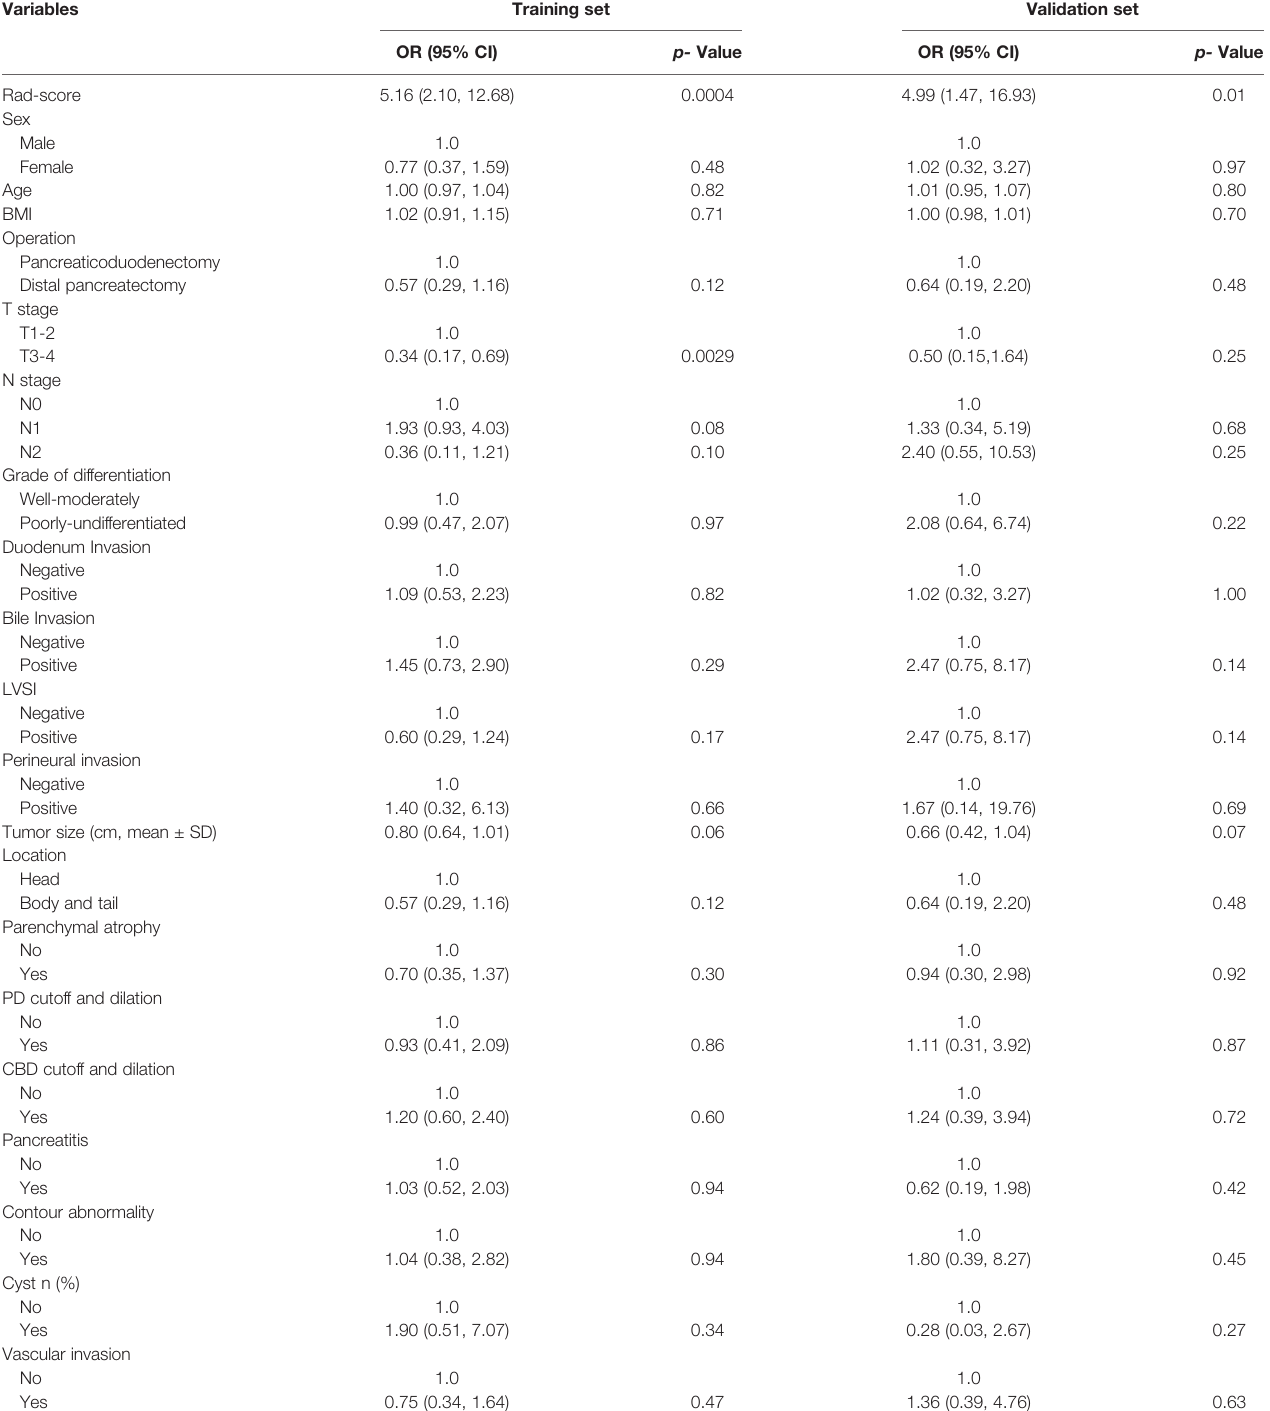
TABLE 3 | The result of univariate